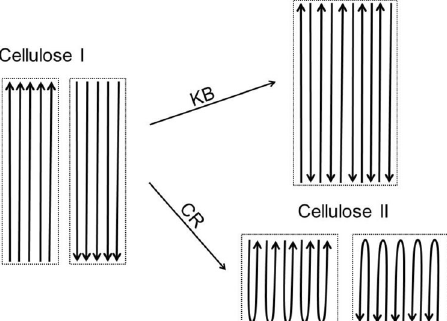
Fig. 2 | Fiber diffraction patterns collected from cellulose I nanocrystals after mercerization to cellulose II. The fi gure is a composite of quadrants from 4 pat- terns.Topleftquadrant:usingX-rays.Toprightquadrant(CD):usingneutronswith H in all nanocrystals replaced by D. Bottom right quadrant (CH): using neutrons withnoDpresent.Bottomleftquadrant(CDH):usingneutronswithHinhalfofthe nanocrystals replaced by D (CDH). The black circle in the center of the image representsthepositionofthedirectbeamasitpassesstraightthroughthesample. Thevertical,meridional,directioncorrespondstothedirectionofthe fi beraxisand the cellulose chains. The equator of the diffraction pattern passes horizontally throughthebeamcenter andcorrespondsto the packingdirectionofneighboring cellulose chains. The position of the (002) meridional and (1 − 10) equatorial dif- fraction intensities is indicated by arrows. The relative differences between the diffracted neutron intensities in (CD), (CH), and (CDH) are due to different dis- tributionsofHandDwithinthesamples.Thepatternofwhitelinesintheseneutron diffraction patterns is due to the way the data are folded together from several different detector positions, as described previously 13